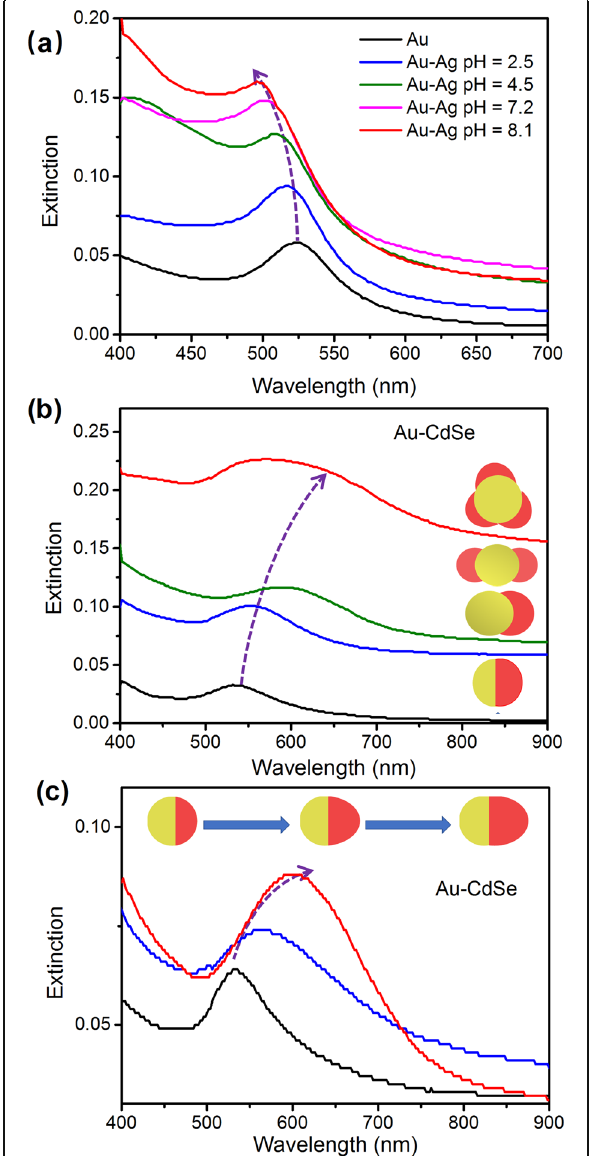
Fig. 6 UV-vis-NIR extinction spectra of a Au and Au-Ag nanoparticles, b Au/CdSe hybrid nanoparticles with different morphologies such as Janus nanospheres (pH = 2.5), heterodimers (pH = 4.5), symmetric double-headed nanoparticles (pH = 7.2), multi- headed nanoparticles (pH = 8.1), and c Au/CdSe Janus nanospheres obtained with different amounts of 0.1 M Cd(NO 3 ) 2 : 0.05 mL, 0.1 mL, and 0.15